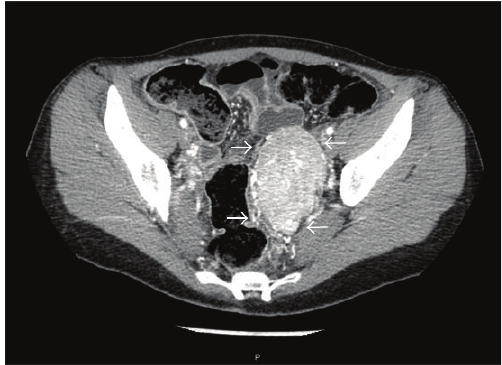
Figure 1: Enhanced pelvic CT scan showing a large mass in the left adnex site.